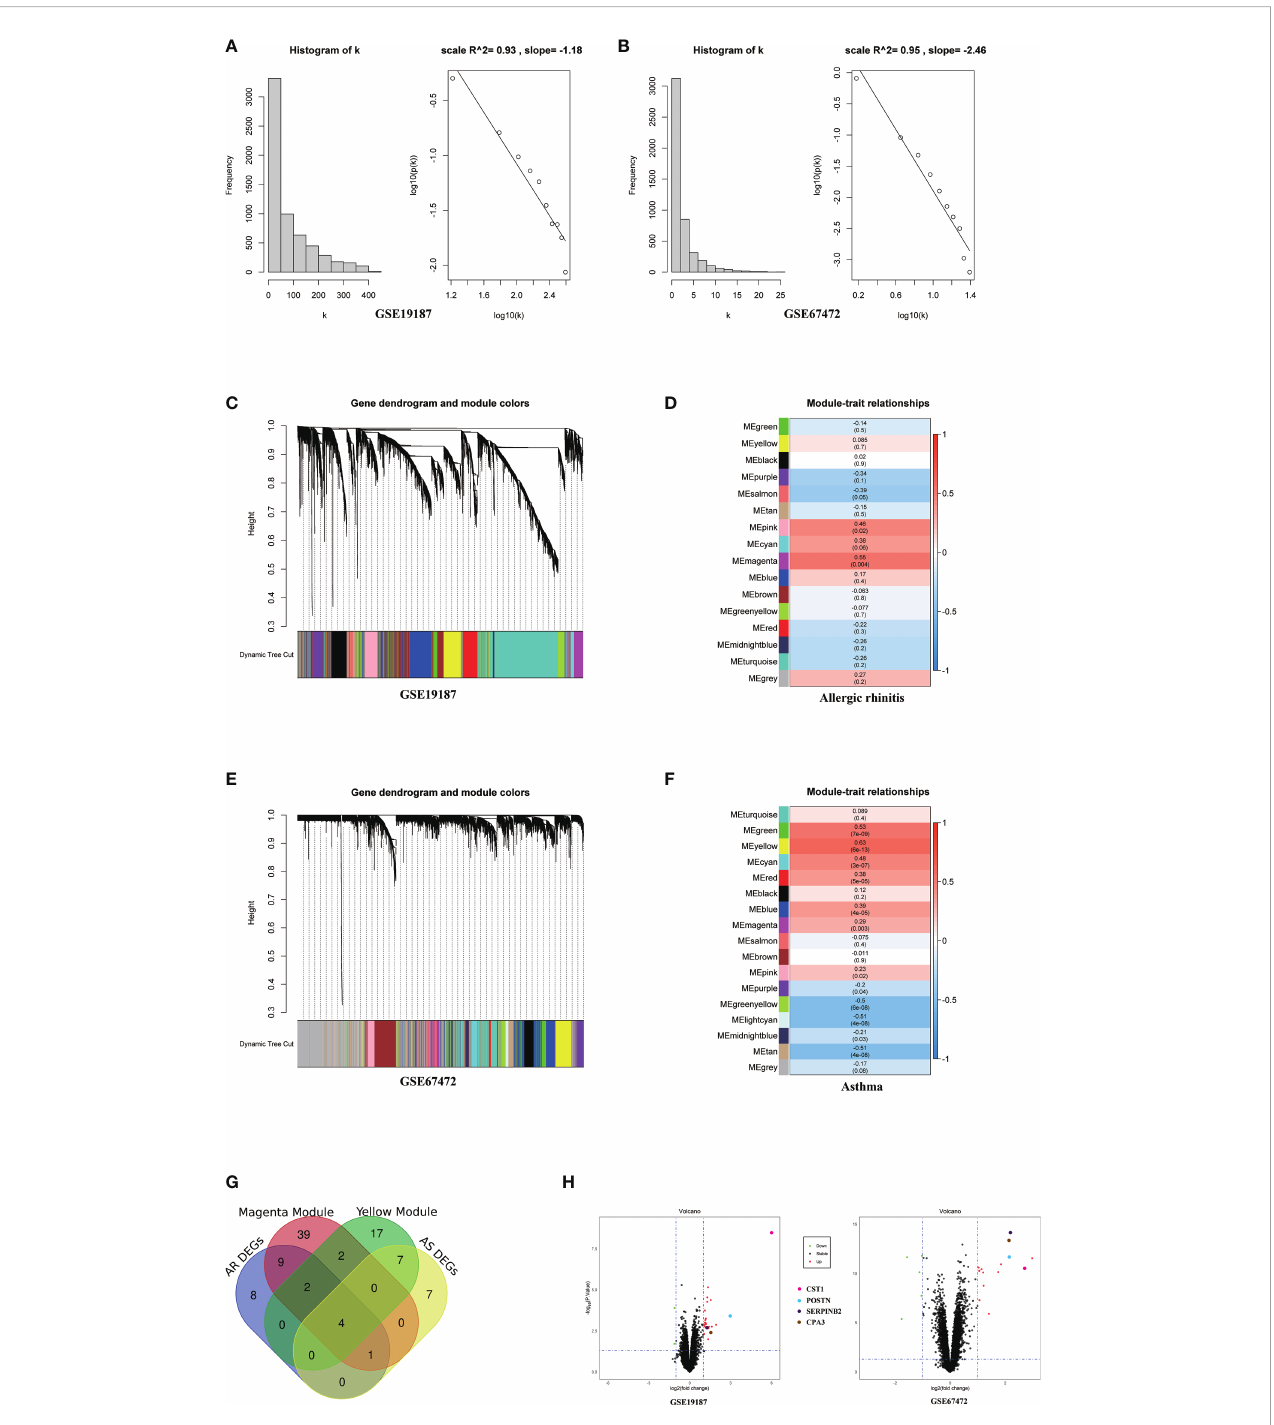
FIGURE 1 WGCNA analysis of GSE19187 and GSE67472. (A) Validation of scale-free networks for GSE19187. The histogram shows the relationship between connectivity (k) and frequency. The scatterplot x-axis represents the log of the overall network connectivity(k), and the y-axis represents the log of the corresponding frequency distribution p(k). There is a negative correlation between k and p(k), and the constructed network conforms to the scale-free network distribution. (B) Validation of scale-free networks for GSE67472. (C) Clustering dendrograms of genes for GSE19187. Different colors below indicate different co-expression modules. (D) The module-trait relationships for GSE19187. Each cell contains the corresponding correlation and p-value; red for positive correlation and blue for negative correlation. (E) Clustering dendrograms of genes for GSE67472. Different colors below indicate different co-expression modules. (F) The module-trait relationships for GSE67472. (G) The Venn diagram shows that a total of 4 key genes were screened from the DEGs and network key modules. (H) The volcano plot shows that four key genes are signi fi cantly up-regulated in both GSE19187 and GSE67472. DEGs, differentially expressed genes; AR, Allergic Rhinitis; AS,